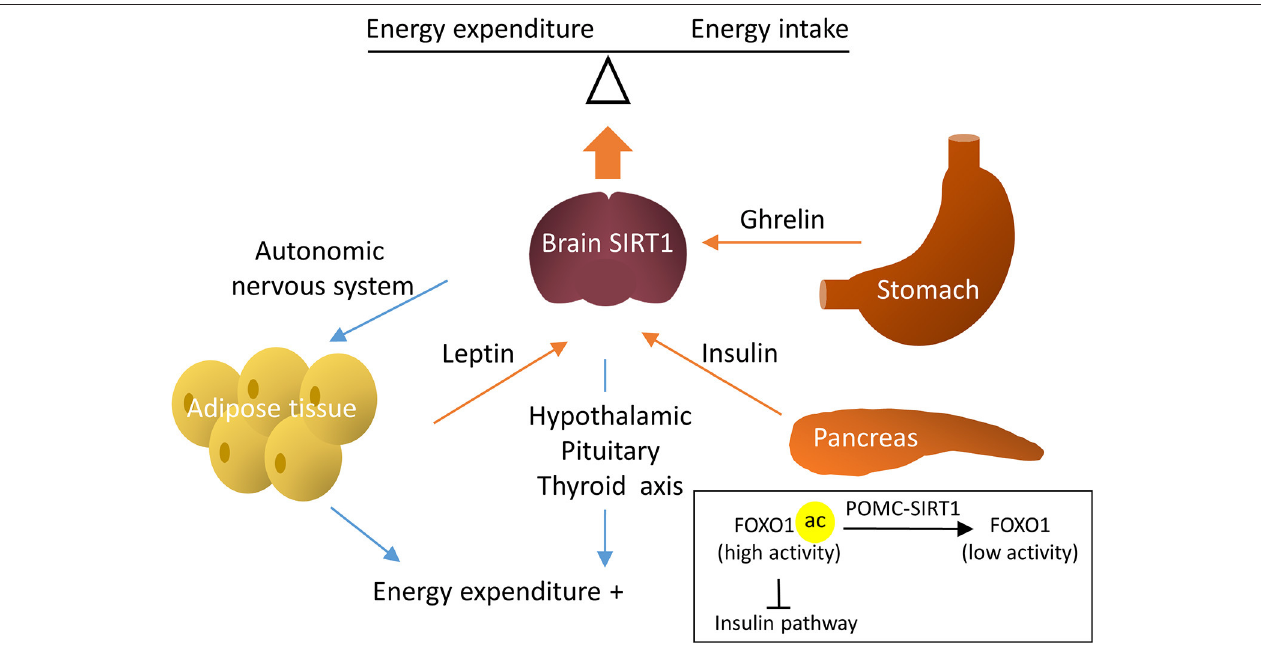
FIGURE 3 | Regulative mechanisms of brain SIRT1 in metabolic homeostasis. Brain SIRT1 increases energy expenditure via the hypothalamic pituitary thyroid axis and increased sympathetic nerve activity in the adipose tissue. In addition, hormones, such as leptin, insulin, and ghrelin through brain SIRT1 to balance energy expenditure and energy intake. For example, SIRT1 in POMC neurons deacetylate Forkhead box protein O1 (FOXO1) to increase the insulin signal